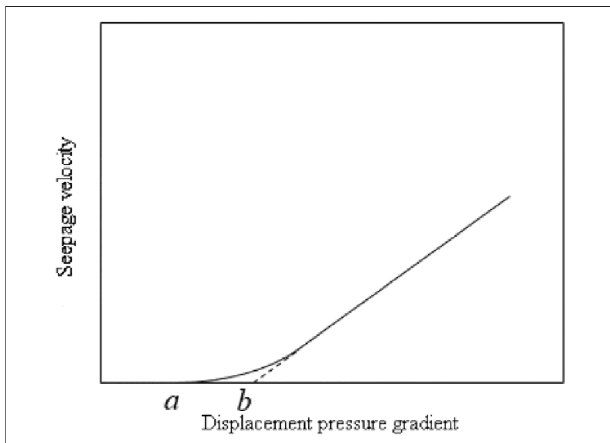
FIGURE 1 | Relation curve between seepage velocity and displacement pressure gradient.